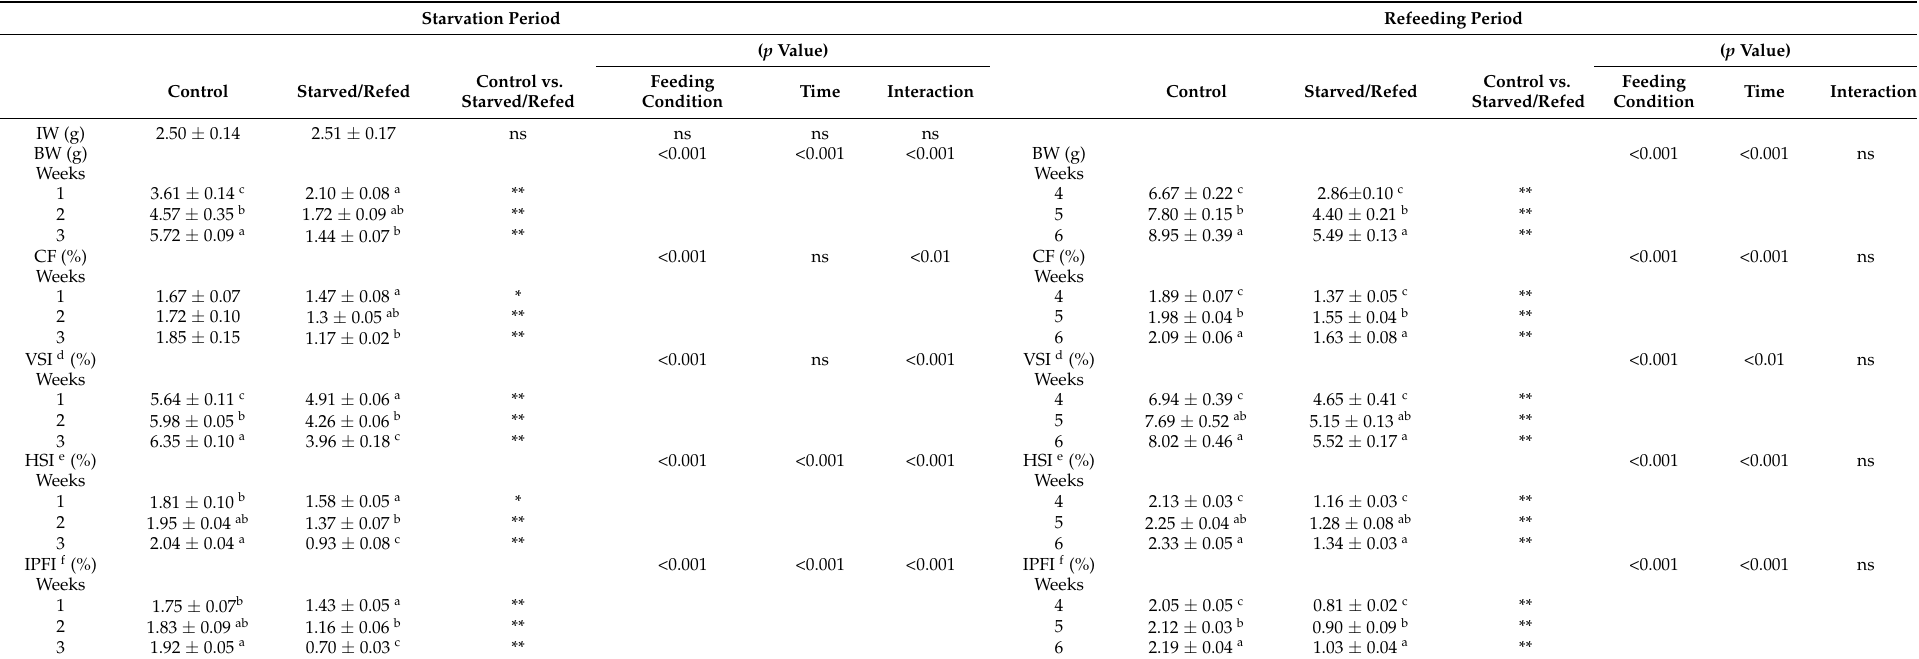
Table 3. Growth and biological indicators of O. macrolepis exposed to starvation and refeeding periods. Starvation Period Refeeding Period ( p Value) ( p Value) Control Starved/Refed Control vs. Starved/Refed Feeding